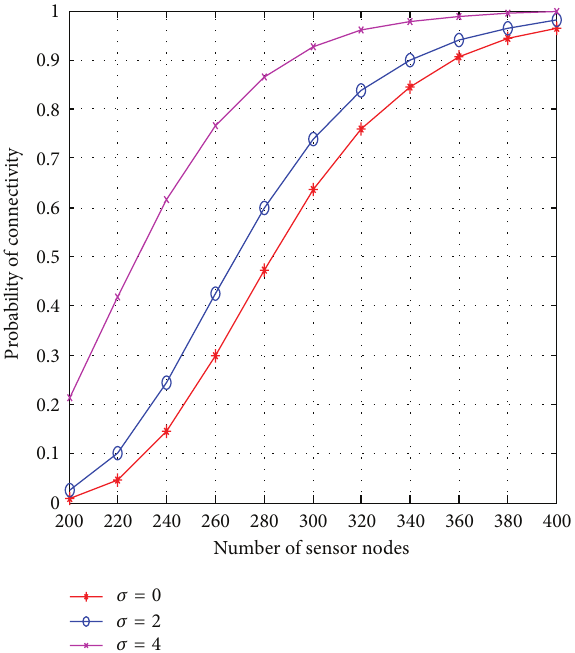
Figure 7: Probability of network connectivity versus sensor nodes.